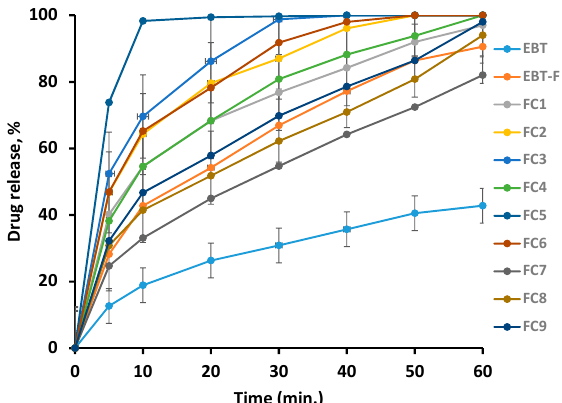
Figure 9. In vitro drug release profile from pure EBT, plain drug-loaded film, and micelles-loaded orodispersible films.